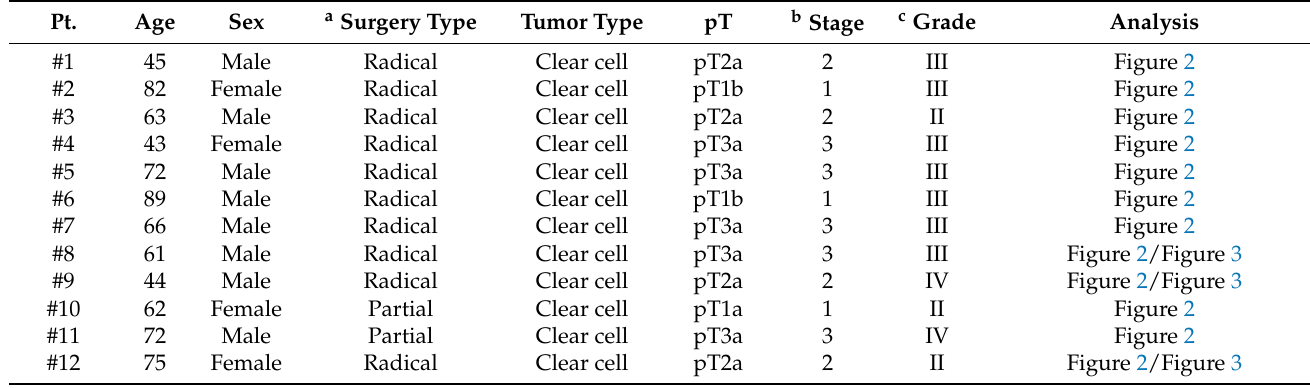
Figure 1. Analysis of γδ T cells within renal cell carcinoma (RCC) and patients’ blood. Experimental schemes: Tumor- infiltrating and blood lymphocytes were analyzed as indicated (TN, T naïve; TCM, central memory T cell; TEM, effector memory T cell). The cytotoxic capacity of each of the sorted γδ T cell populations was assessed for their cytotoxic capacity against Caki-1 and ACHN RCC cell lines. Table 1. Patient samples and clinical characteristics.